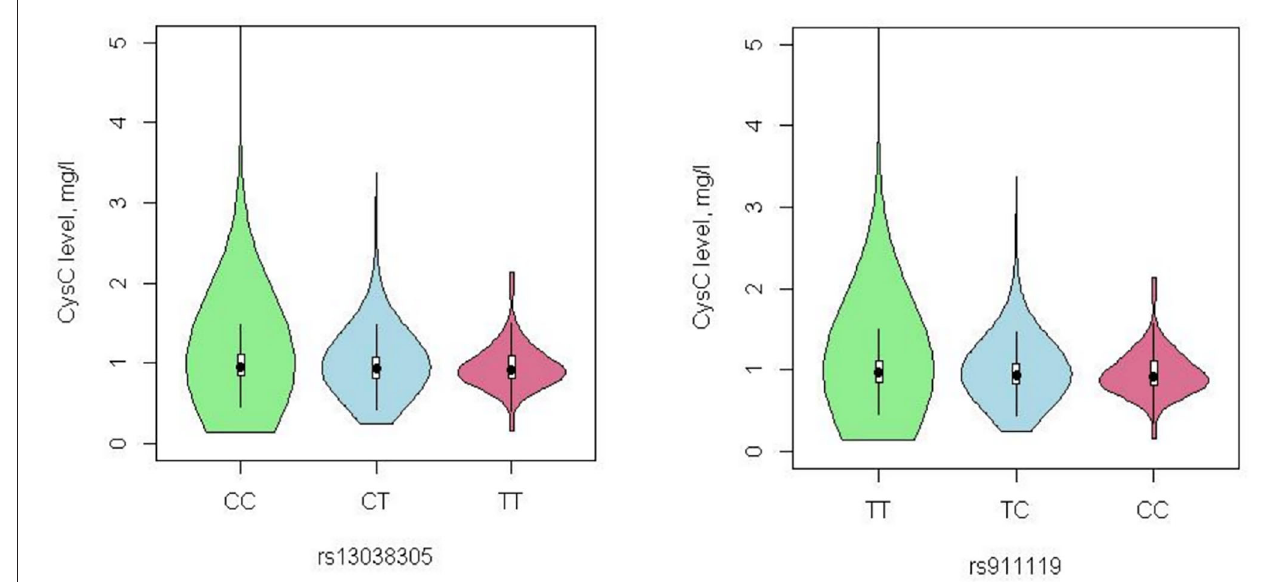
FIGURE 1 | Cystatin C content in different genotype